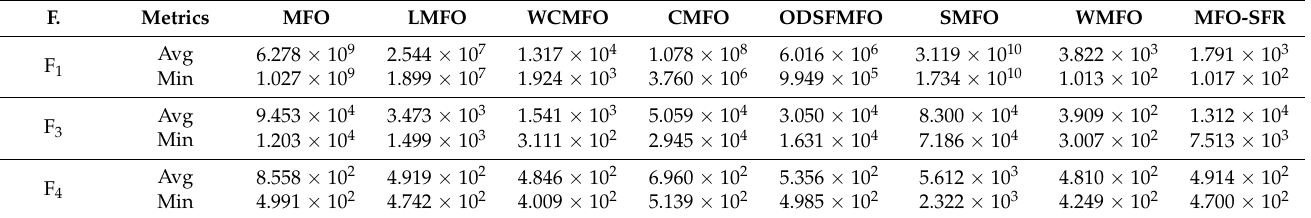
Table 3. Comparison of MFO-SFR with MFO variants for CEC 2018 test functions with D = 30.